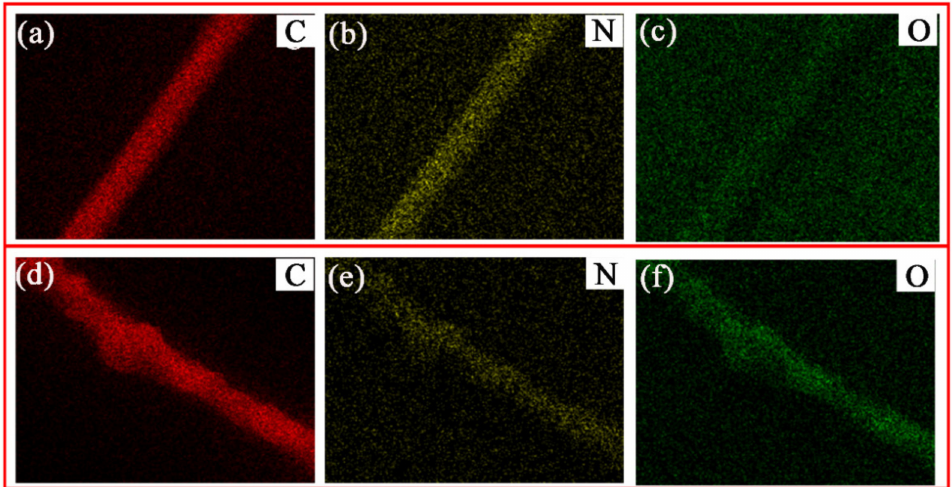
Figure 3. EDX maps of C, N and O elements in PAN ( a – c ) and PDA@ PAN ( d – f ) nanofibers.